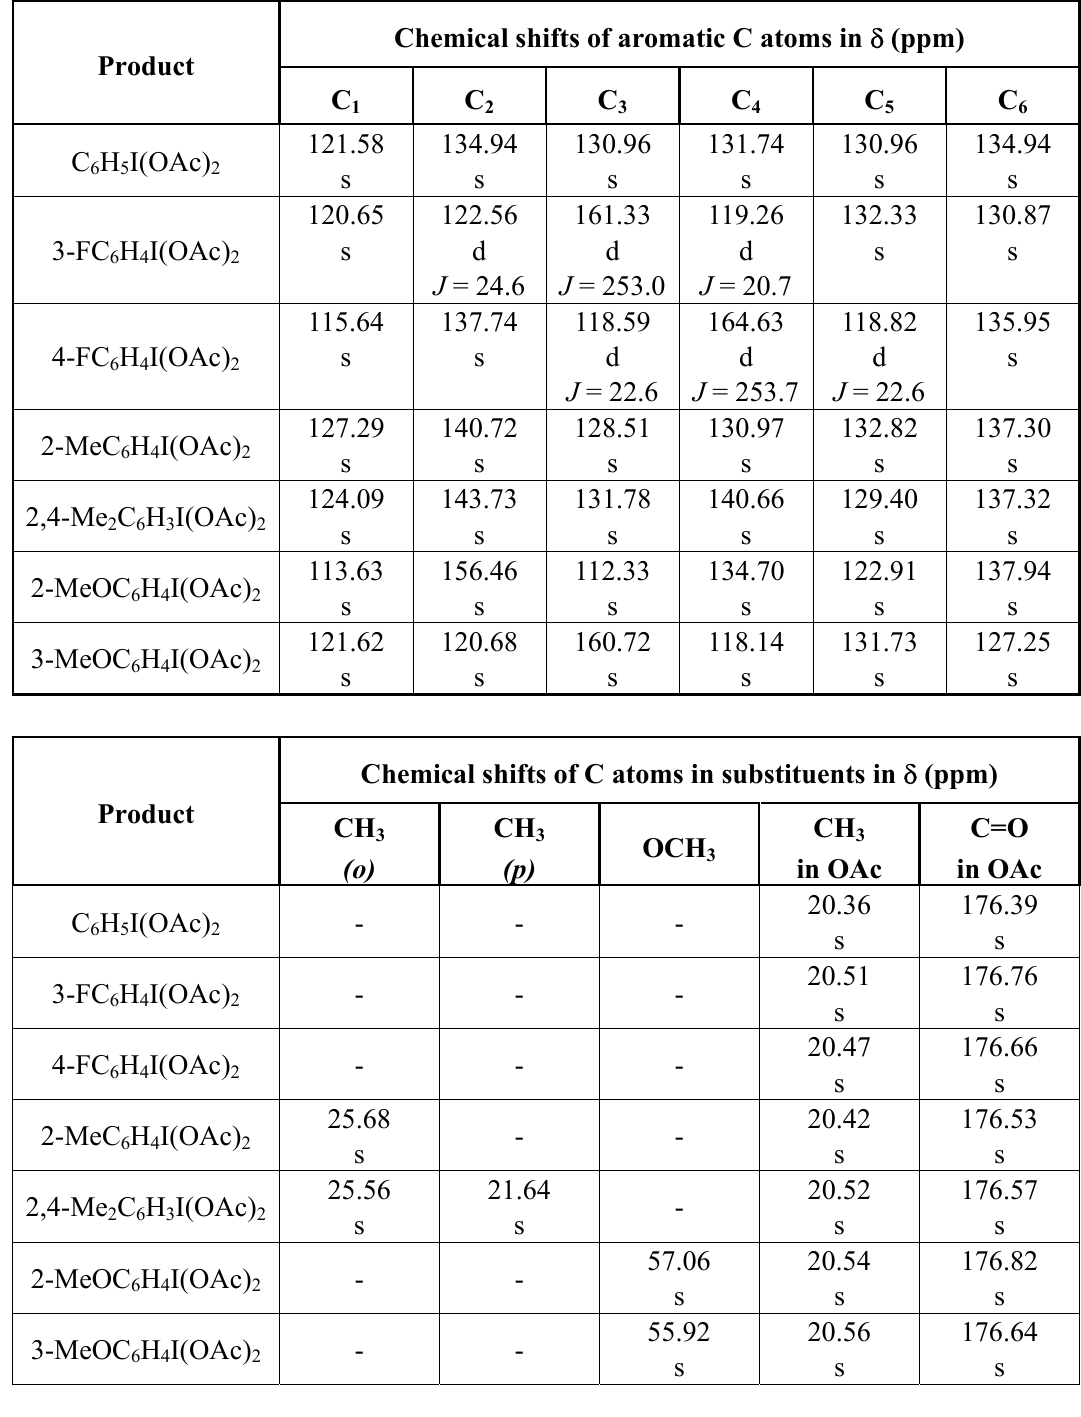
Table 3. 13 C NMR chemical shifts for pure (diacetoxyiodo)arenes and coupling constants J J and (Hz). Cf. our present experimental values with those CF 1319 − CCF 1319 −− previously reported incompletely [10,